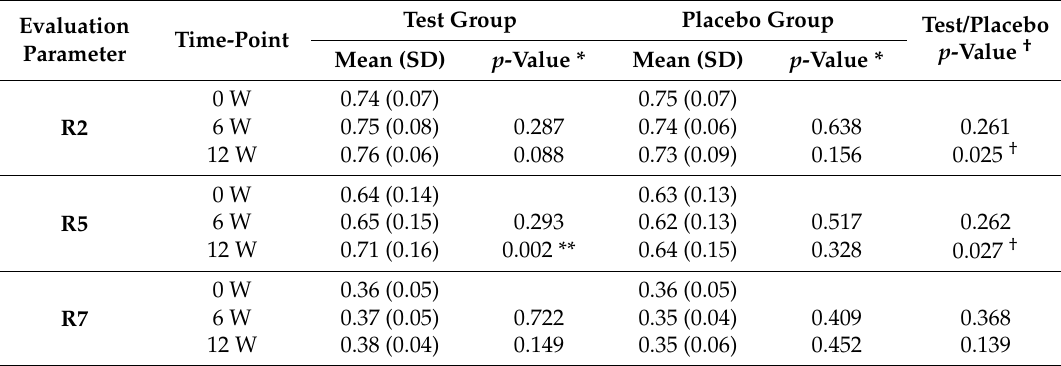
Figure 4. Changes in skin-elasticity parameters in individuals receiving Low-molecular-weight Collagen peptide (LMWCP) preparation or placebo. Skin elasticity was measured with a Cutometer MPA580. ( A ) Changes in skin-elasticity parameter R2 (overall elasticity). ( B ) Changes in skin-elasticity parameter R5 (net elasticity). Changes in parameter values from baseline are shown in arbitrary units (AU). Data are expressed as the mean ± SEM. For t -test comparisons with baseline values, ** indicates p < 0.01. For t -test comparisons between the test group and the placebo group, † indicates p < 0.05. Table 7. Skin elasticity measured by Cutometer MPA580.